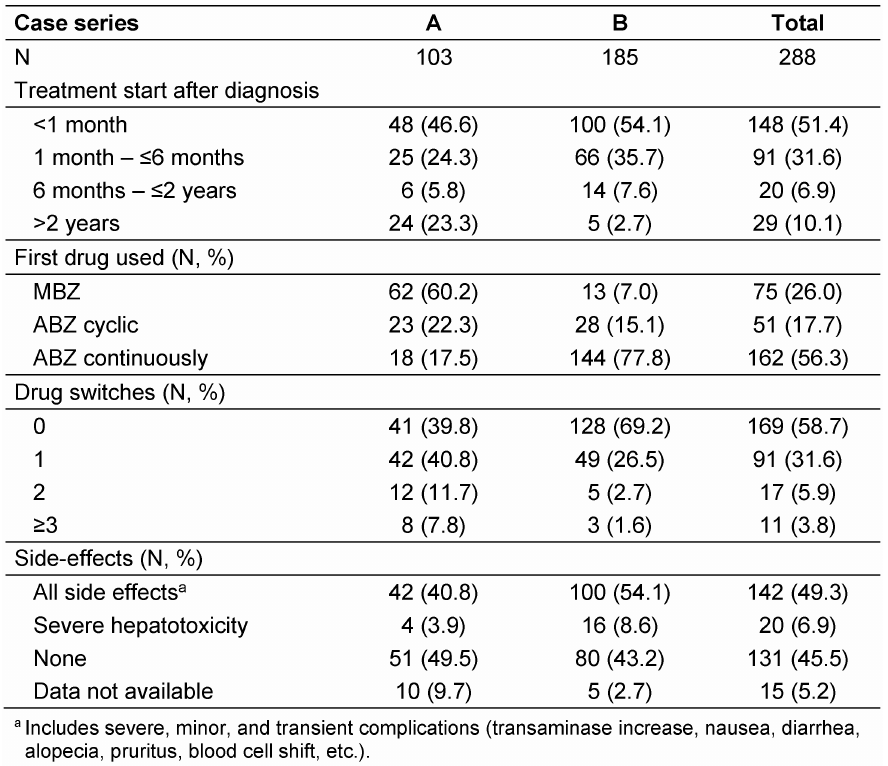
Table 6: Benzimidazole treatment and